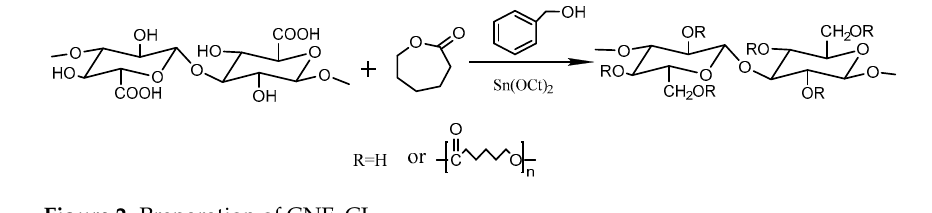
Figure 2. Preparation of CNF–CL.